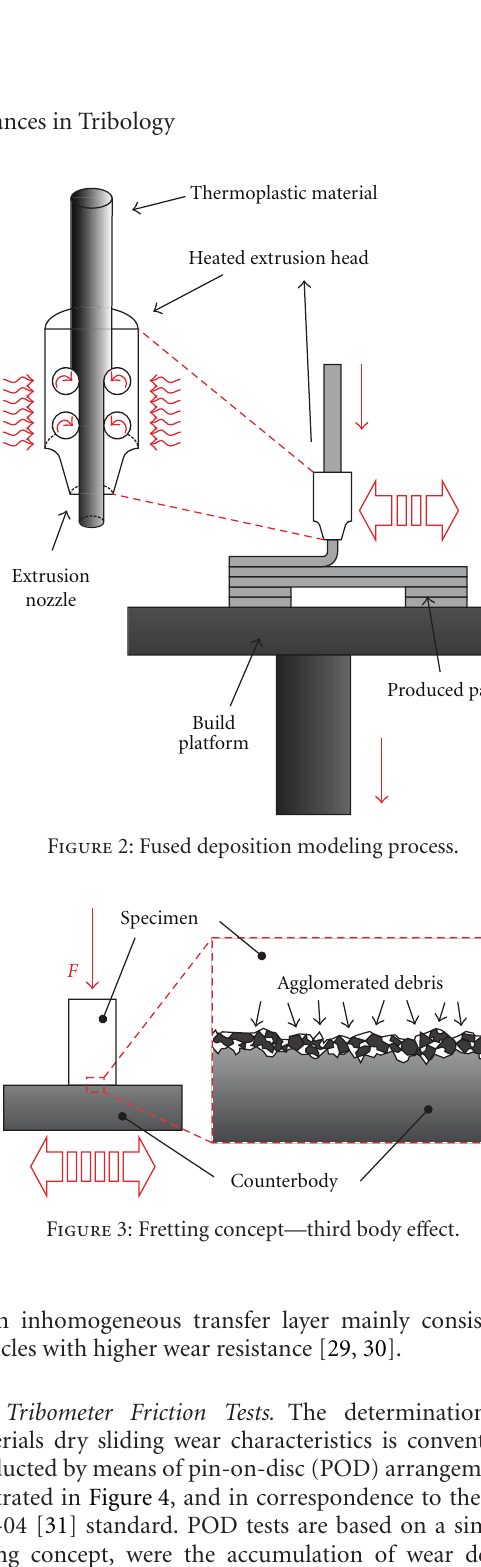
of an inhomogeneous transfer layer mainly consisting of particles with higher wear resistance [29, 30].